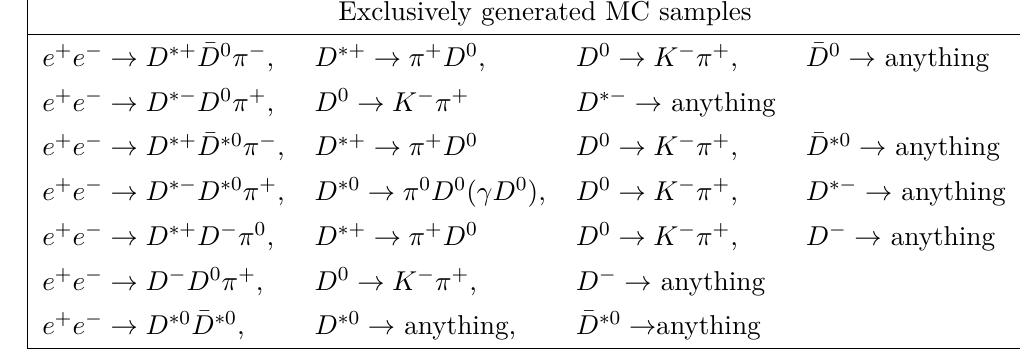
Table 3. The decay chains of the exclusively generated MC samples for background